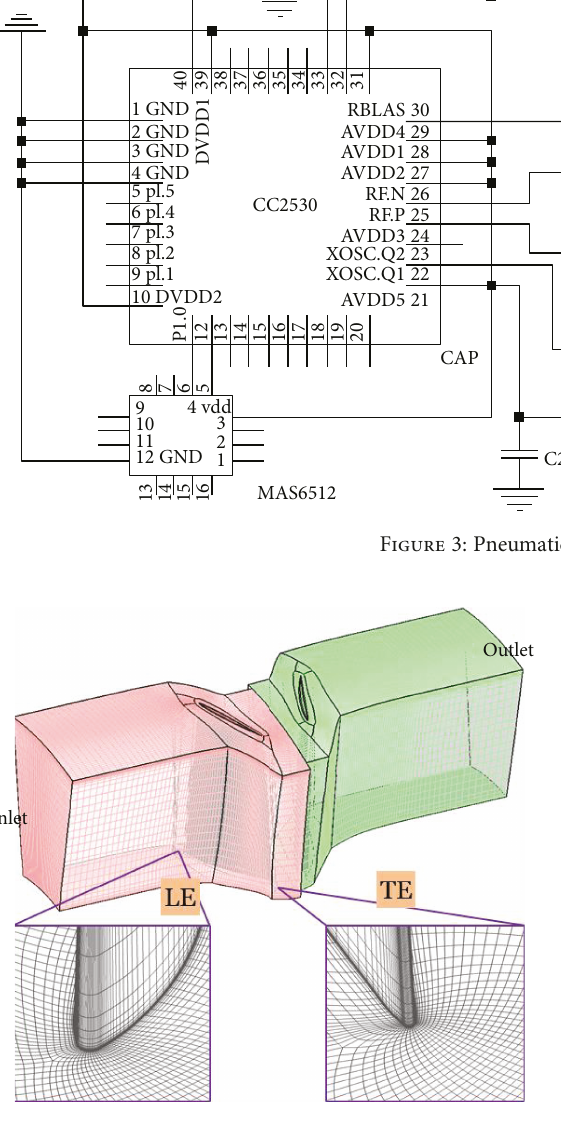
Figure 4: The computational mesh of the two